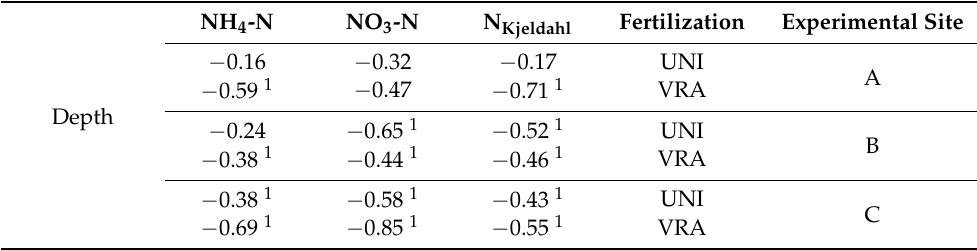
Table 4. Correlation between the content of N forms in soil profile and soil depth, calculated separately for A, B, C experimental sites.